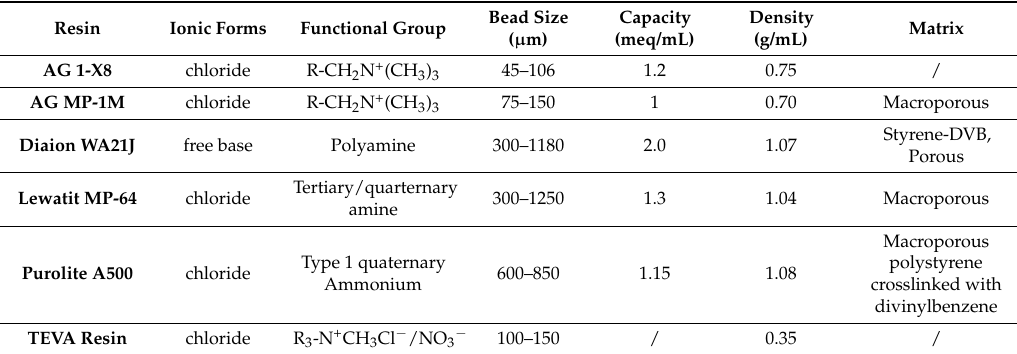
Table 1. The physical properties of the resins employed in this